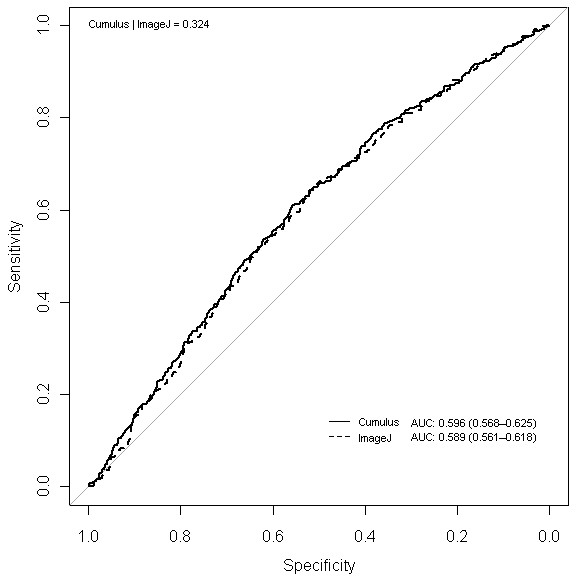
Discriminatory powers of Cumulus and ImageJ for predicting breast cancer risk, as measured by area under curve (AUC). Legend on the top-left corner summarizes P values for the Delong test between two receiver operating characteristic (ROC) curves. Legend on the bottom-right corner summarizes the AUC for each model with corresponding 95% confidence intervals.